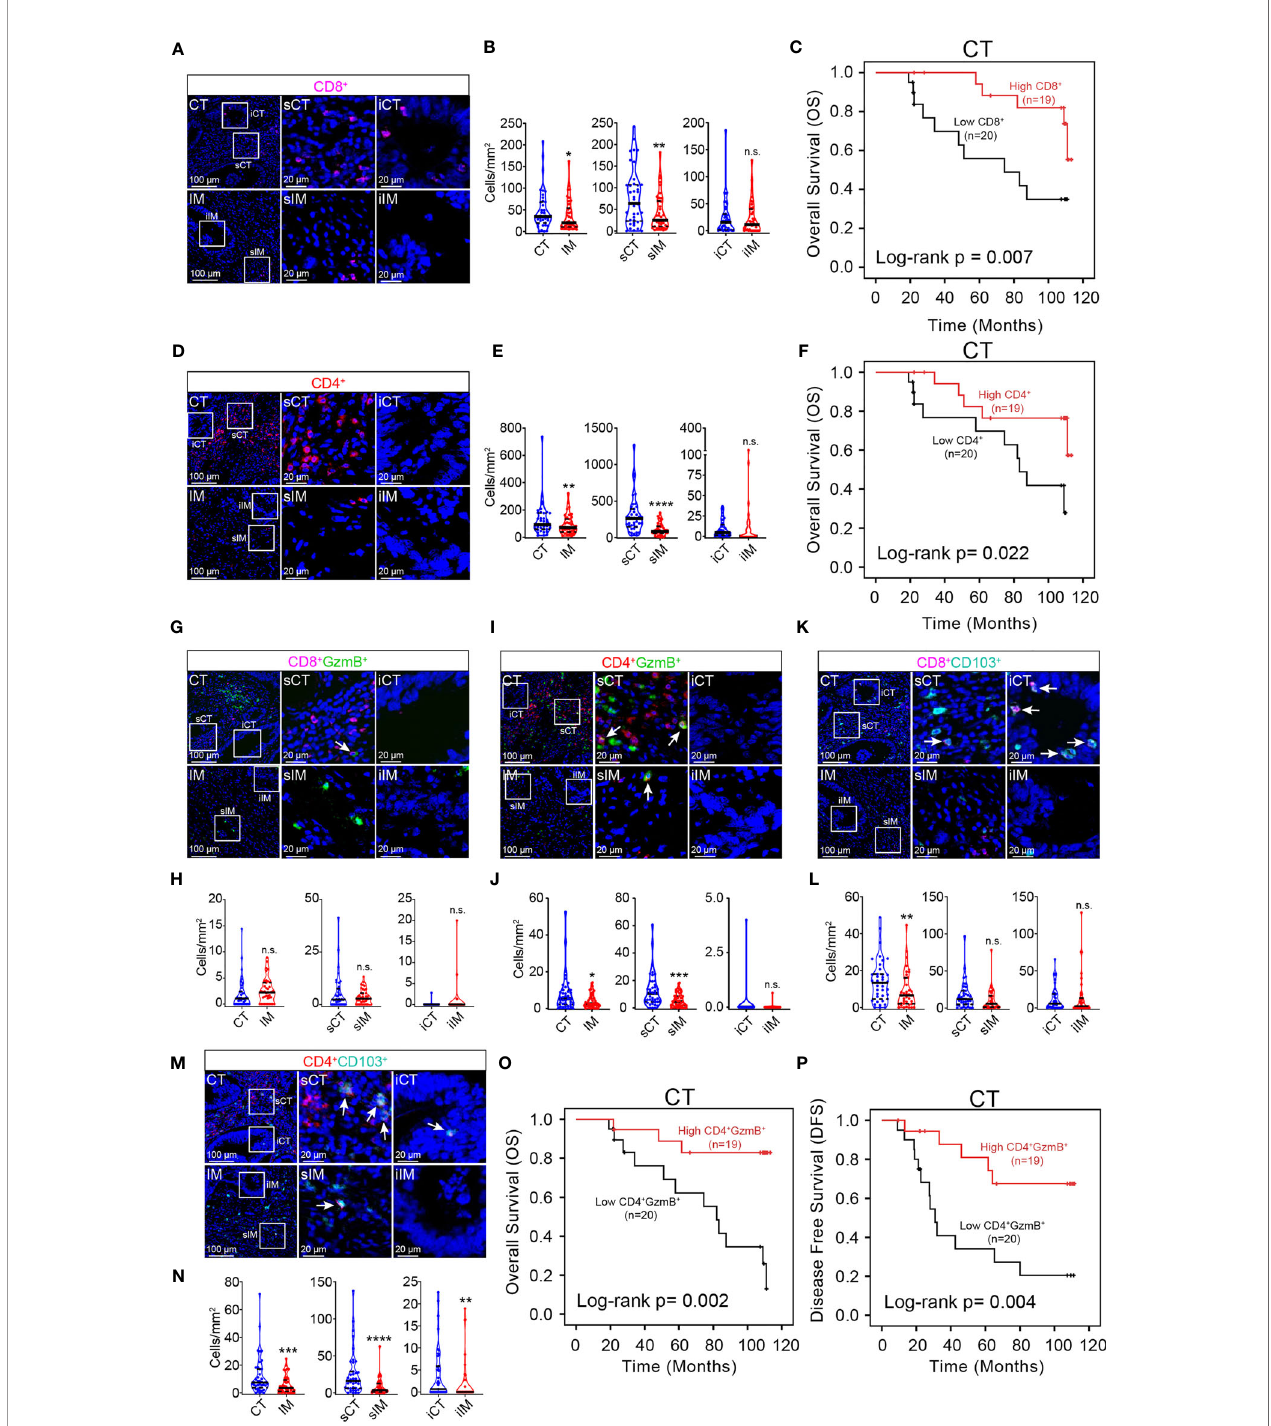
FIGURE 1 | mIHC helpsidentifyimmune prognosticmarkersinpMMR CRC patients.RepresentativemIHCimagesofpMMR CRCnottreatedwithNCTshowthespatial distributionpatterns ofCD8 + Tcells (A) ,CD4 + Tcells (D) CD8 + GzmB + Tcells (G) ,CD4 + GzmB + Tcells (I) , CD8 + T RM cells (K) andCD4 + T RM cells (M) inCT andIMregion.The violinplotsprovide statisticalcomparisonsfor the densityofCD8 + Tcells (B) , CD4 + T cells (E) ,CD8 + GzmB + T cells (H) , CD4 + GzmB + Tcells (J) ,CD8 + T RM cells (L) andCD4 + T RM cells (N) inCTandIM region.Thethickdashedlines andthindottedlinesdenotethemedianandinterquartilerange,respectively. Statisticalsigni fi cances weredetermined via Wilcoxonmatched-pairssignedranktest, with* P < 0.05,** P < 0.01,*** P <0.001,**** P < 0.0001,n.s. notsigni fi cant. Univariatesurvivalanalysisofpatientswas performedto assess theOSandDFSaccordingtothedensityofCD8 + Tcells (C) ,CD4 + Tcells (F) , andCD4 + GzmB + T cells (O,P) intheCT, usingthe Kaplan-Meier